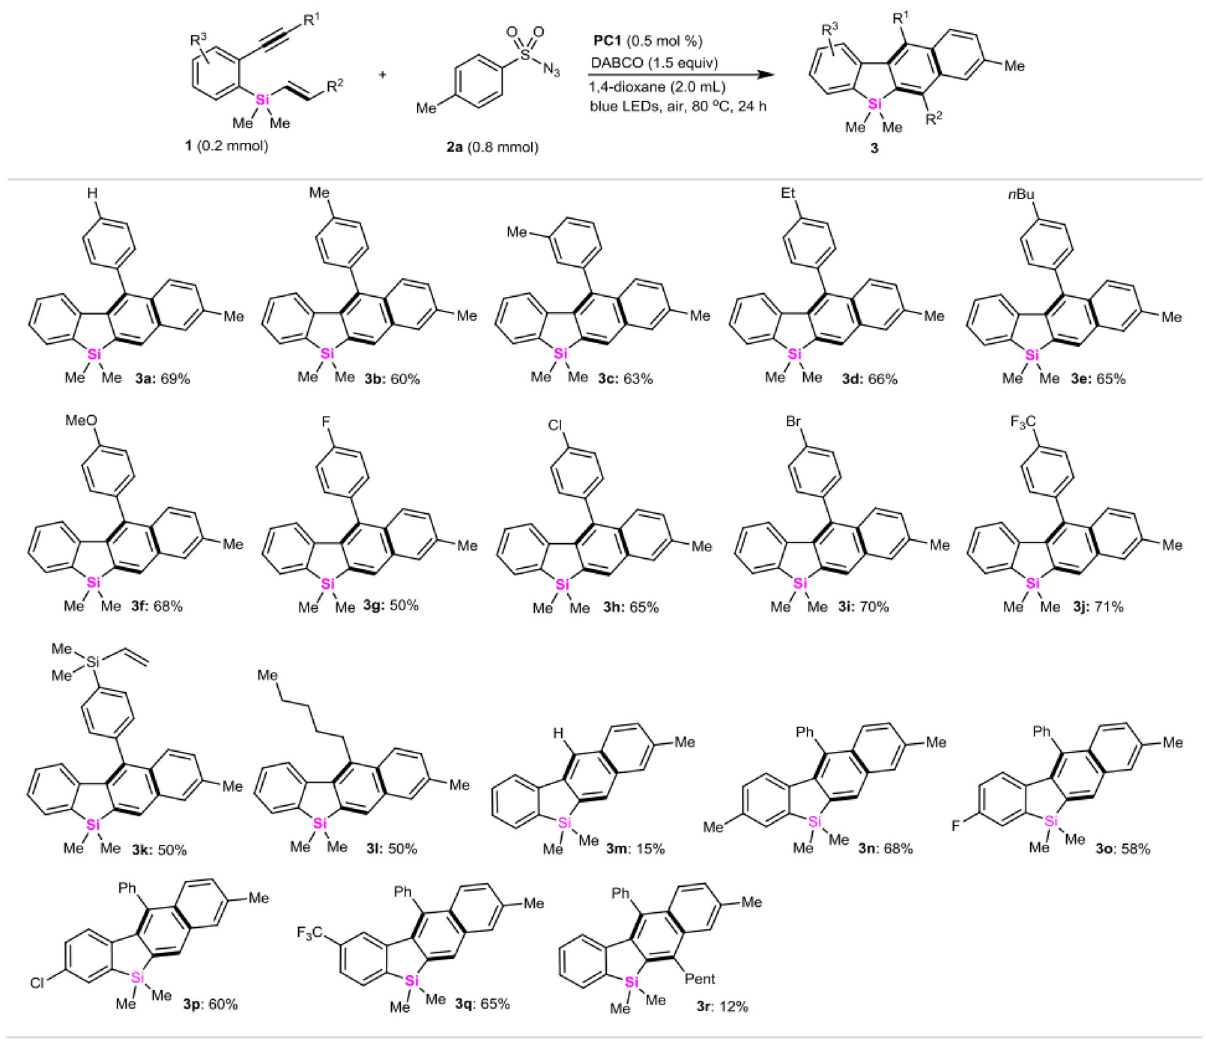
Fig. 3 Sila-enyne scope. All the reactions are conducted in sealed tubes, followed by fl ash chromatography on SiO 2 . The isolated yields are reported.